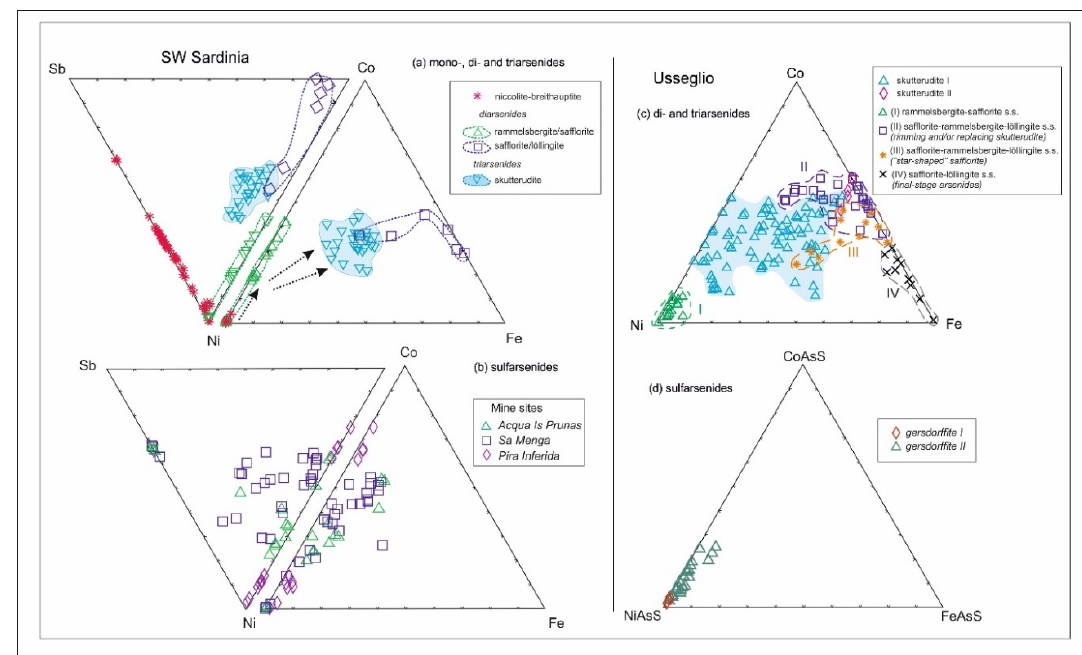
Figure 6. Plots of the data of arsenides and sulfarsenides (atomic%). ( a , b ) ternary diagrams comparing Ni, Co, Fe, and Sb components for mono-, di-, and triarsenides and for sulfarsenides–sulfantimonides in the SW Sardinian vein system; ( c , d ) ternary diagrams comparing Ni, Co, and Fe components for di- and triarsenides and for sulfarsenides in the Usseglio vein system.